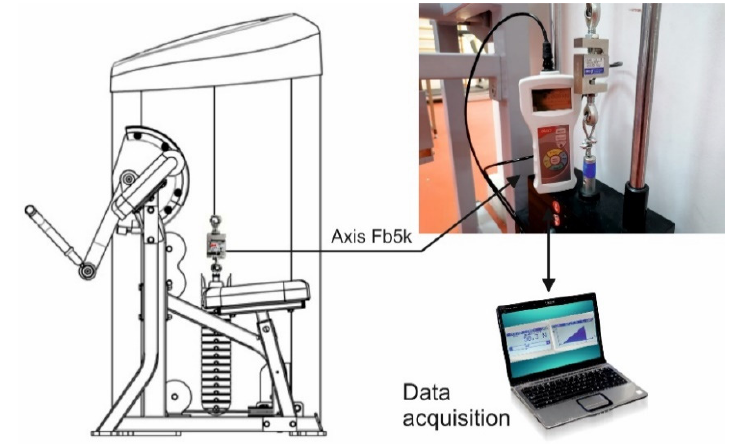
Figure 1. Experimental setup.